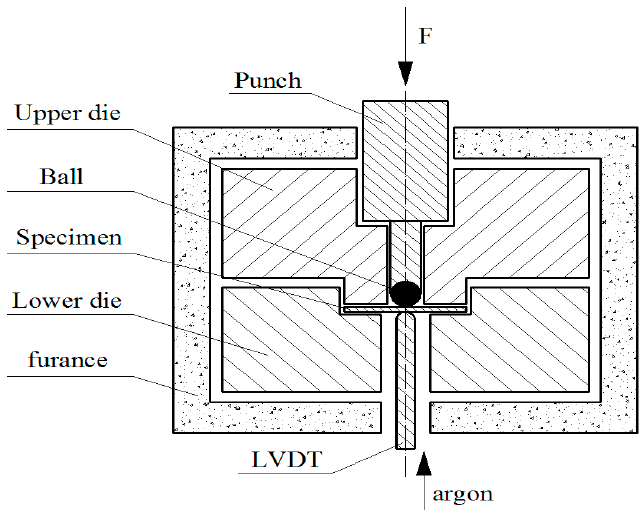
Figure 2. Principle sketch of the small punch test device.